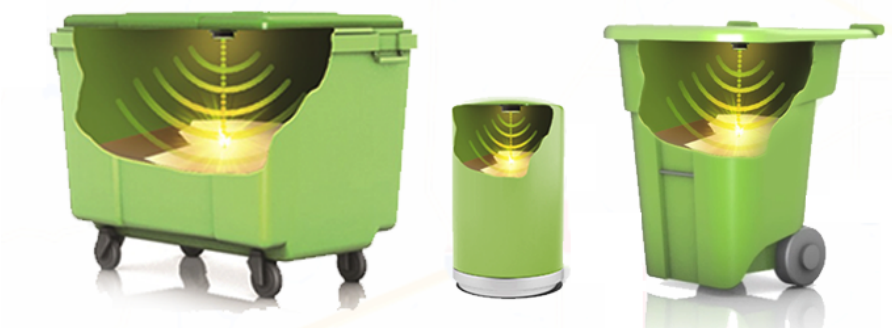
Figure 3. Schematic of indicative sizes of smart bins with integrated